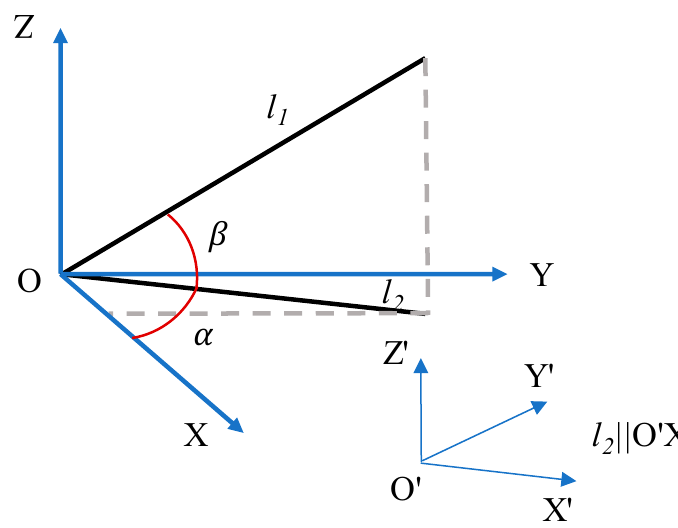
Figure 3. Rotation method for inclined elements.